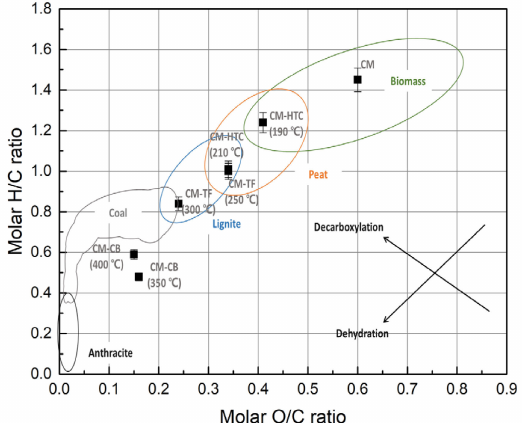
Figure 3. The van Krevelen diagram of the cattle manure, hydrochars, torrefied chars, and